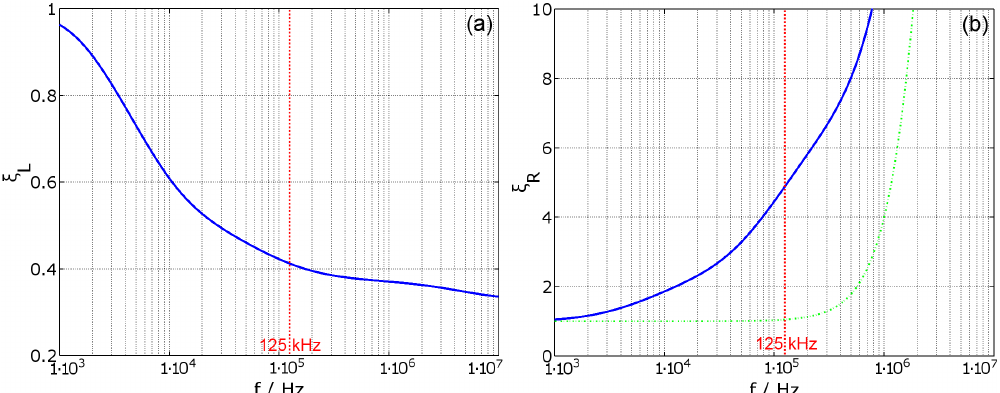
Figure 3. Correction factors ξ L for the main inductance ( a ) and ξ R for the equivalent series resistance ( b ). Additionally, in ( b ), the alternating current (AC) resistance factor ξ Rac without housing is plotted in dashed green, which shows the dominance of the skin- and proximity effect above the frequency f ac = 1MHz. The parameters, belonging to coil ’A’ are N A = 200 and